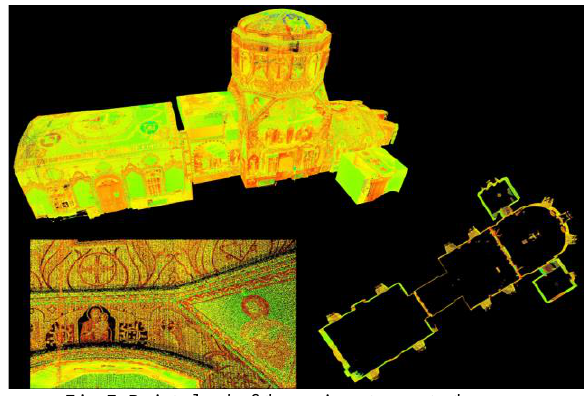
Fig. 7. Point cloud of the main entrance to the caves